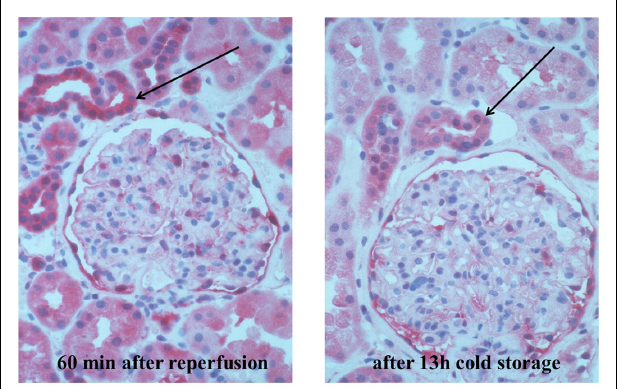
FIGURE 1 | Immunohistochemical demonstration of expression of the inducible heat shock protein 70. The renal biopsy specimen shows a human kidney removed from a brain-dead donor, perfused with the UniversityWisconsin preservation solution, and cold-stored over 13h.The biopsy was taken before (right) and 60min after reperfusion (left) following implantation into the recipient. Demonstration was performed using the monoclonal antibody HSP 6B3 (GSF, non-commercially available), specific for inducible heat shock component HSP 70 (formerly HSP72c) in a dilution of 1:150, at room temperature, for 1h. A detection system APAAP (alkaline phosphatase–antialkaline phosphatase) from the rat (Fa Dako) is used, by incubation with linking antibody and staining with fast red. Sources: Further properties (e.g., specificity) of the monoclonal antibodies are described in: Milani et al. (2002) and Arbogast et al. (2002). Permission: Reproduced with permission of: LandWG. Innate Alloimmunity, Part 2. Innate Immunity and Allograft Rejection , and Ba¸skent University, Pabst Science Publishers,